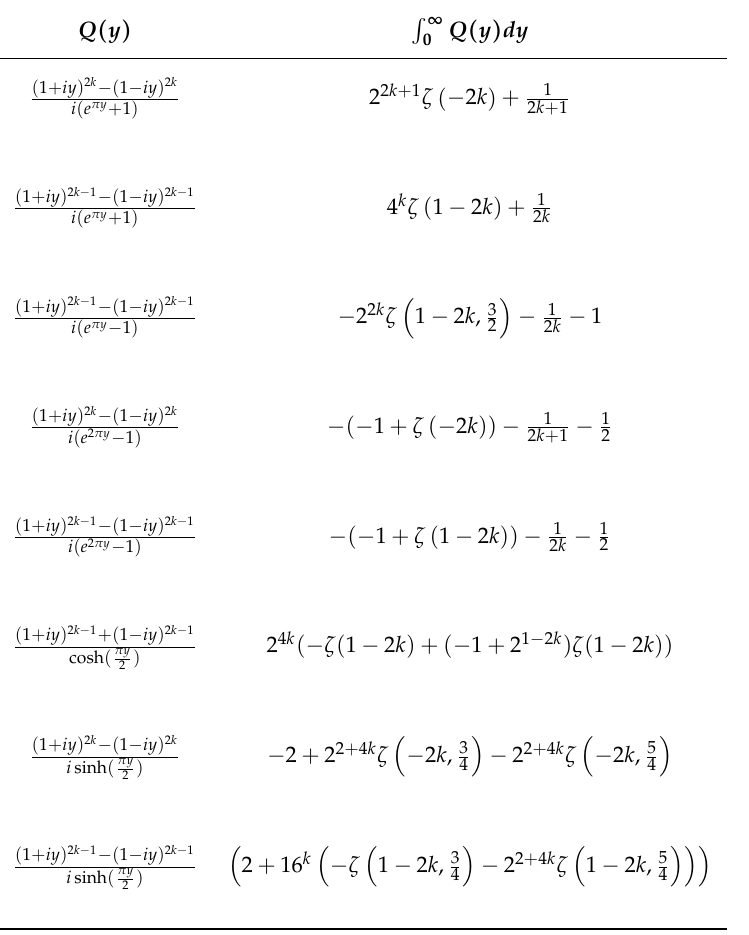
Table 1. Table of